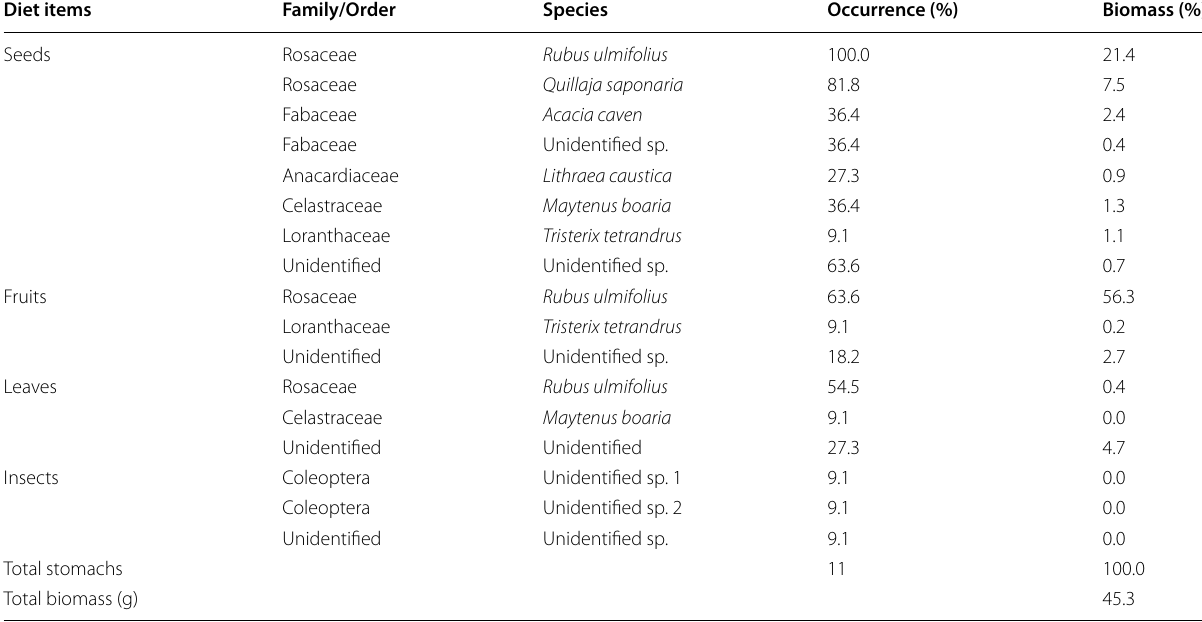
Table 3 California Quail diet in central Chile during autumn 2022 based on numerical frequency of occurrence over 11 stomachs and by total